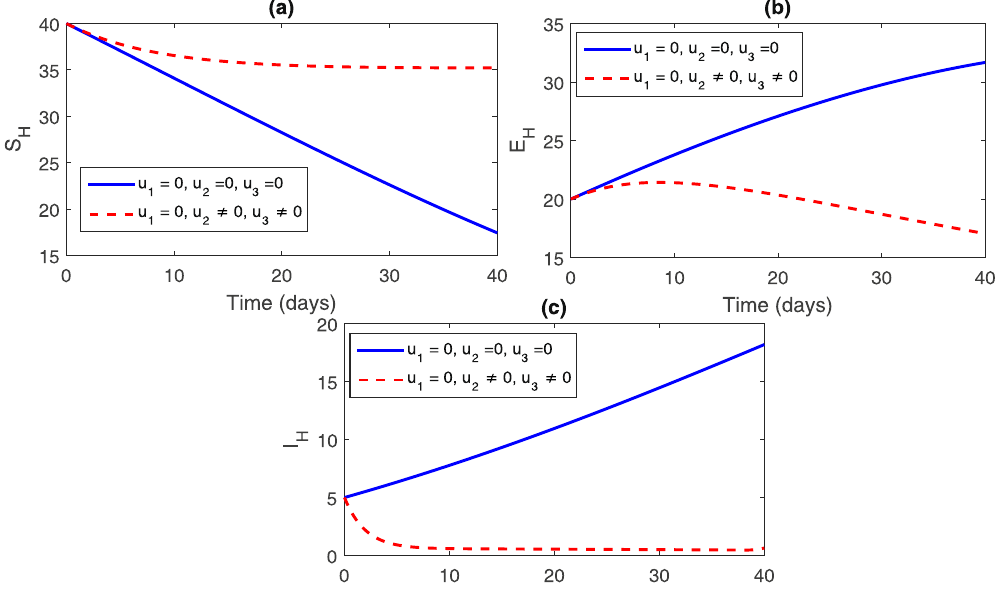
Figure 2. Comparison of both the systems: without and with